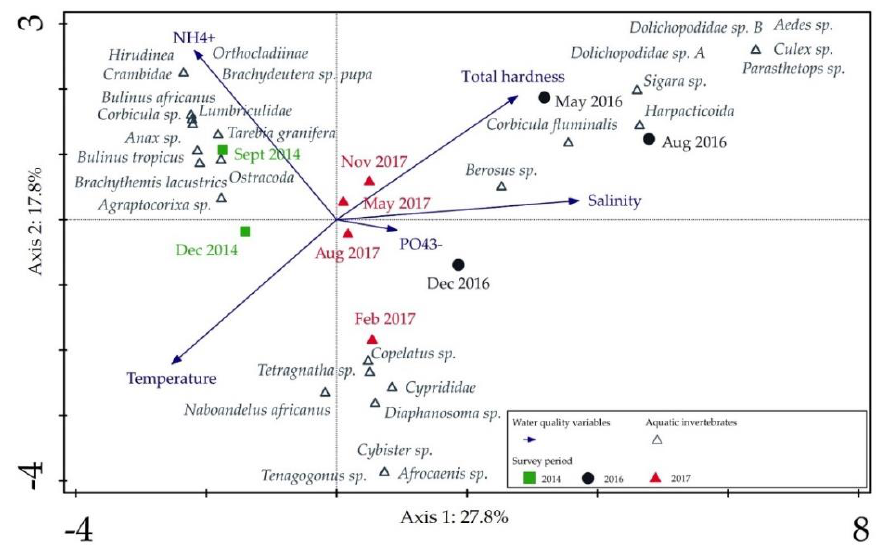
Figure 3. Canonical correspondence analysis (CCA) plot comparing aquatic invertebrate diversity and select water quality variables to all sampling surveys during 2014 (predrought), 2016 (drought) and 2017 (recovery) in Lake Nyamithi. The plot explains 45.6% of data variation of which 27.8% is explained by axis 1 and 17.8% by axis 2. Only the 30 best fitting aquatic invertebrate taxa and water quality variables selected through correlation and forward selection analysis are presented. Table 2. Measured water quality variables for each sampling surveys in 2014 (predrought), 2016 (drought) and 2017 (recovery) from Lake